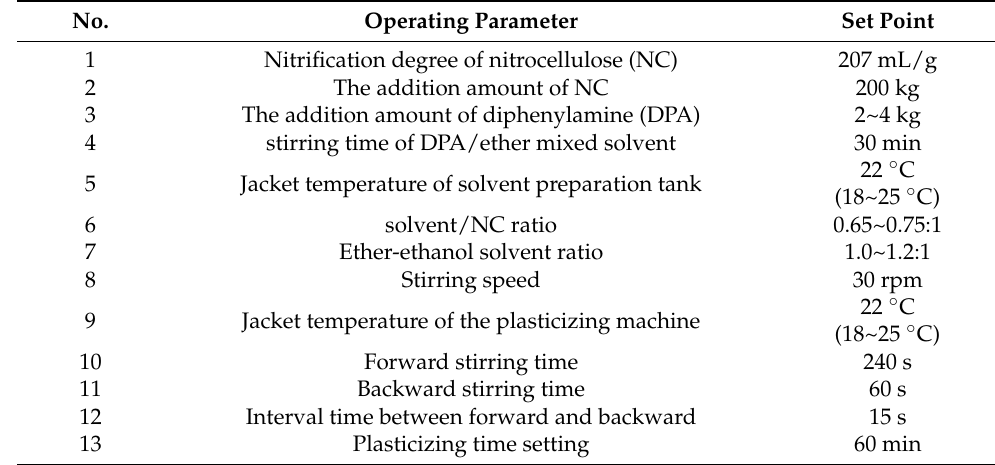
Table 1. Operation condition setting for plasticizing